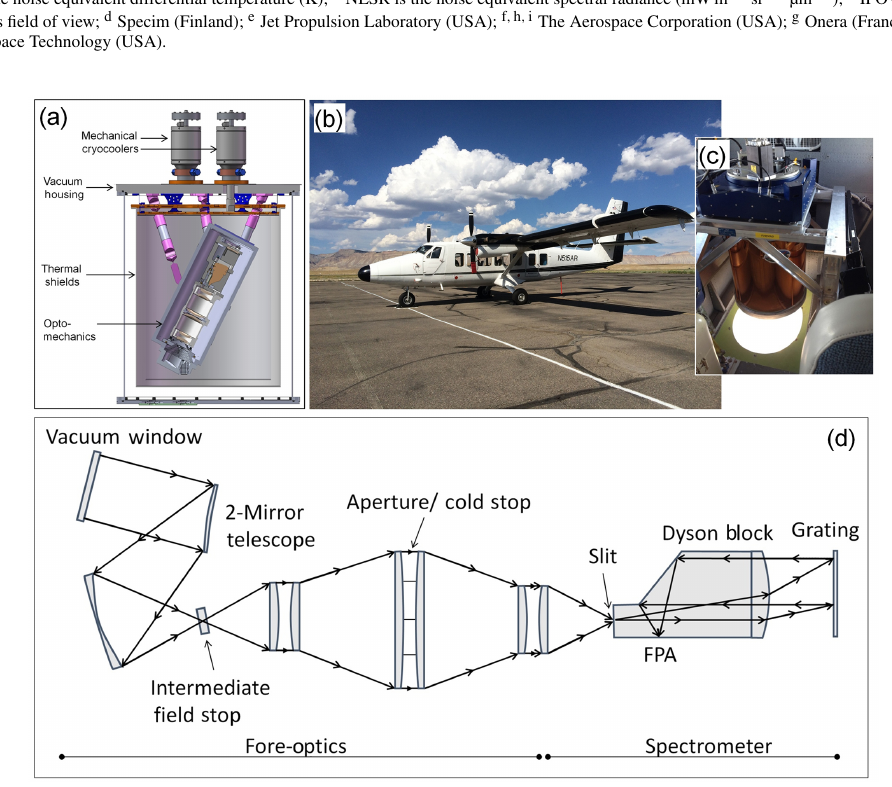
Figure 1. (a) HyTES design and optical layout, (b) Twin Otter aircraft, (c) HyTES installation in aircraft, and (d) , optical layout highlighting ray trace through the Dyson spectrometer and objective lens